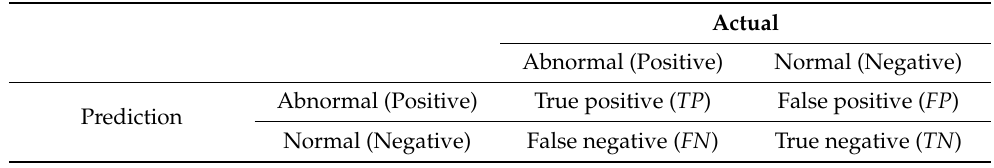
Table 4. The confusion matrix for outcome of